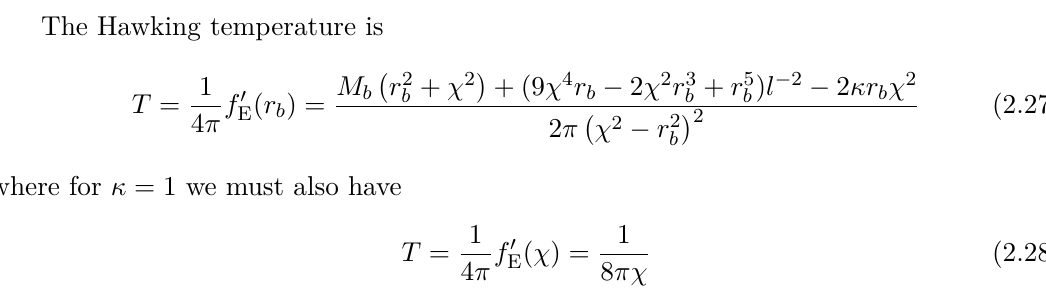
Figure 1 . The horizon radius r b (2.29) vs. NUT charge for uncharged TB-AdS for κ = 1 and G = l = 1